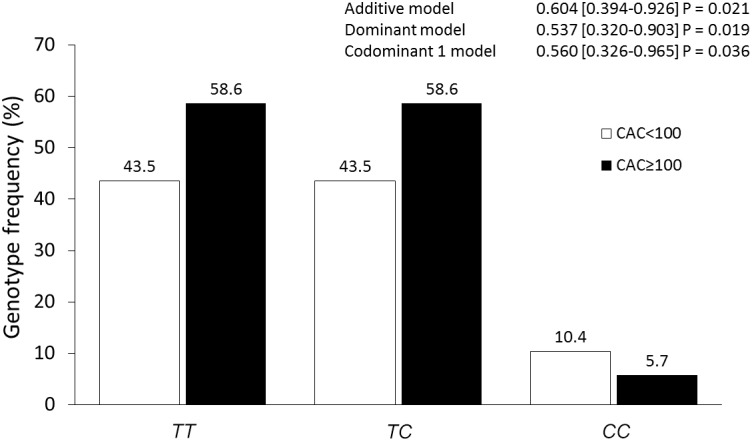
Association of the rs2155209 polymorphism with CAC severity. The models were adjusted for age, gender, body mass index, current smoking, hypertension, type 2 diabetes mellitus, low density lipoprotein cholesterol concentrations.